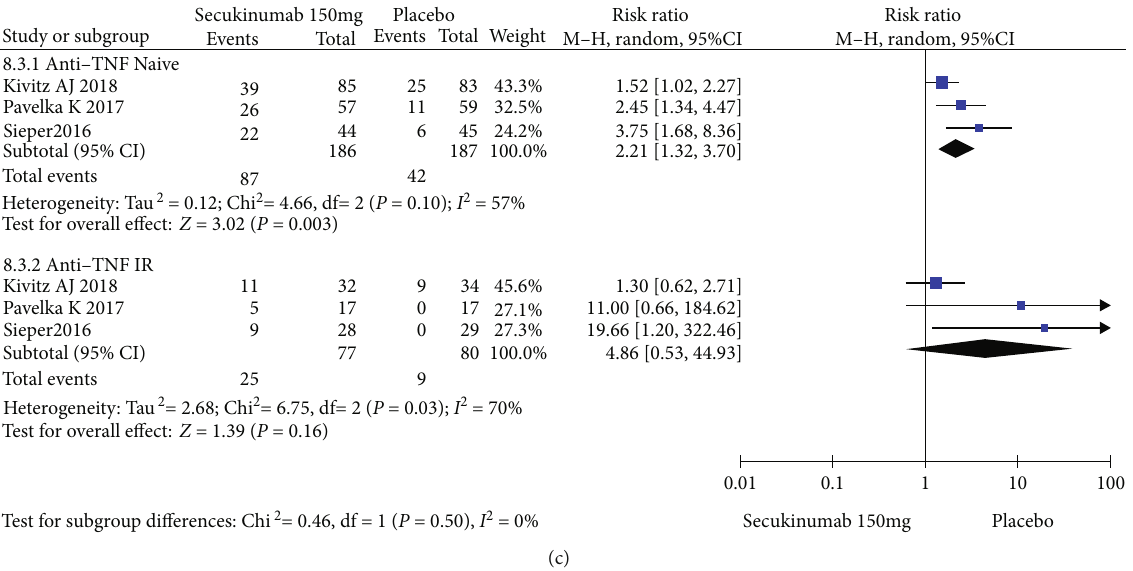
Figure 6: Subgroup analysis of secukinumab 150mg versus placebo at week 16. (a) ASAS 20 response, (b) ASAS 40 response, (c) ASAS 5/6